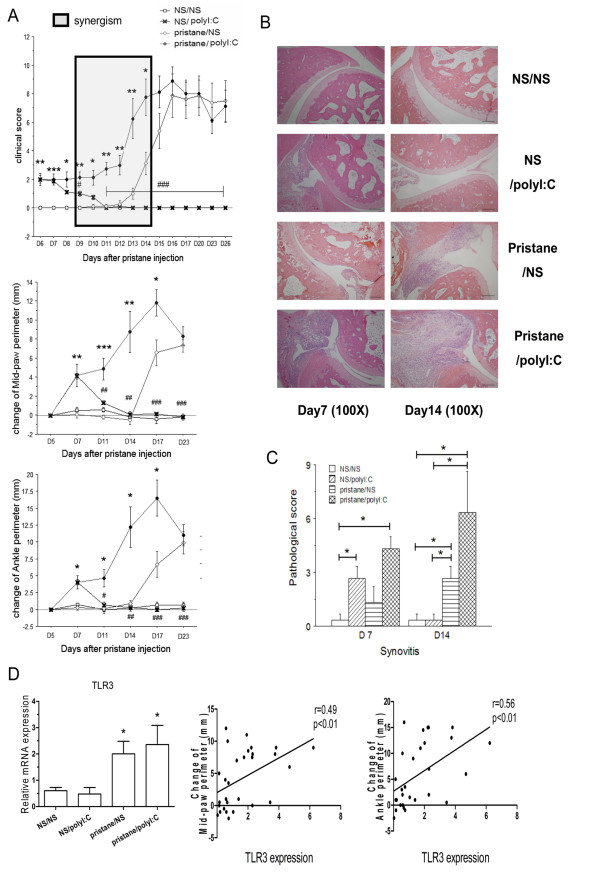
More severity and increased histopathological scores of PIA caused by poly(I:C) local treatment. (A) Poly(I:C) or NS was intra-articularly injected into different ankle cavities of each PIA rat and each control rat, and the arthritis clinical indexes, including clinical score, changes in midpaw perimeter and ankle perimeter of the paws, were compared among four groups (eight paws in each group). Clinical data were calculated using the Mann-Whitney U test (*/#P < 0.05, **/##P < 0.01, ***/###P < 0.001). *Pristane/poly(I:C) group vs. pristane/NS group. #Pristane/poly(I:C) group vs. NS/poly(I:C) group. Shaded box represents a synergistic effect assessed by two-way analysis of variance. (B) Representative histological images of ankle joints from each group at D7 and D14 are shown (H & E stain; original magnification, ×100). (C) Synovitis scores were quantified for histological analysis. Pathological data were calculated using the Mann-Whitney U test (*P < 0.05). *Comparison between groups as marked. (D) mRNA expression of TLR3 in synovium of each joint (eight joints in each group) at D26 was measured by real-time PCR. Values are presented as means ± SEM. Gene assay results were calculated by using Student's t-test (*P < 0.05). Correlation between TLR3 expression and the clinical indexes was measured by using Spearman's σ analysis.